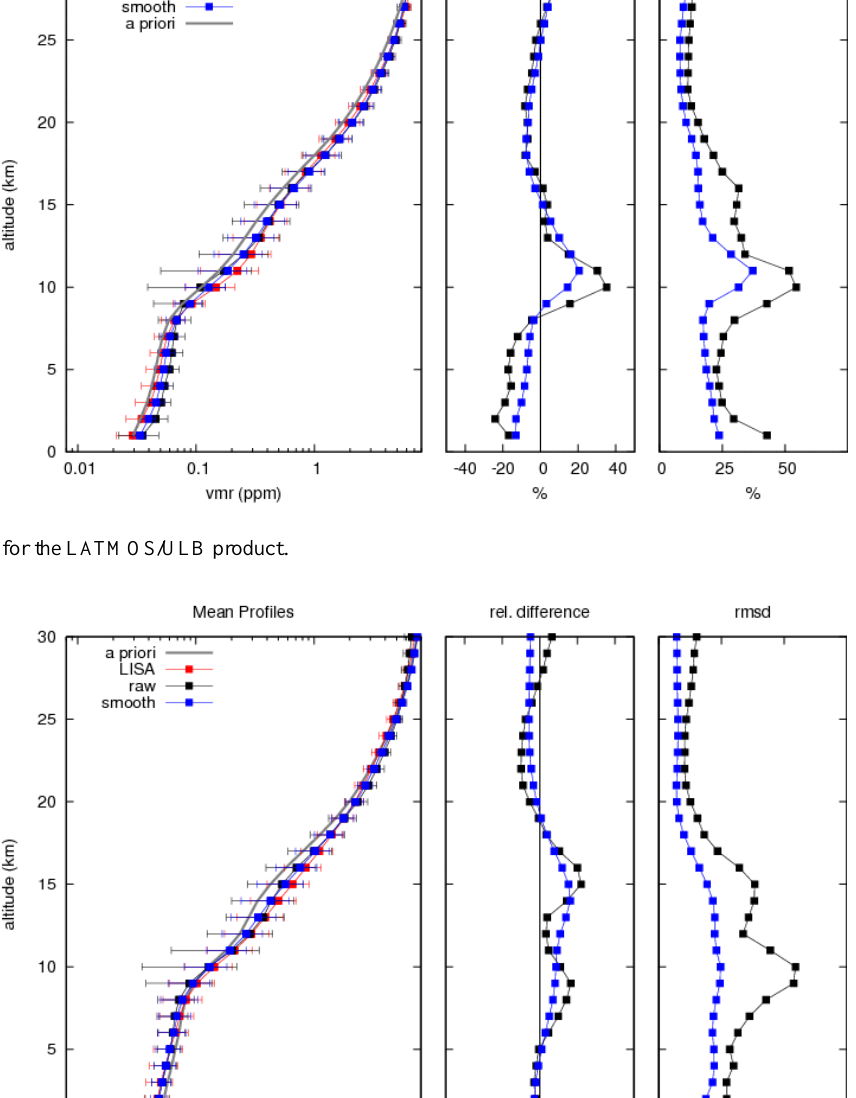
Figure 6. Standard deviation (%) of the mean partial columns of ozone averaged over the set of pixels defined for the validation in the case of the LA product over the entire year 2008 (top), over winter (middle), and over summer (bottom). The standard deviation is given for the retrieved columns, the measured ozonesonde columns and the smoothed ozonesonde columns. It represents the variability of ozone. The definition of the partial columns is given in section 3.